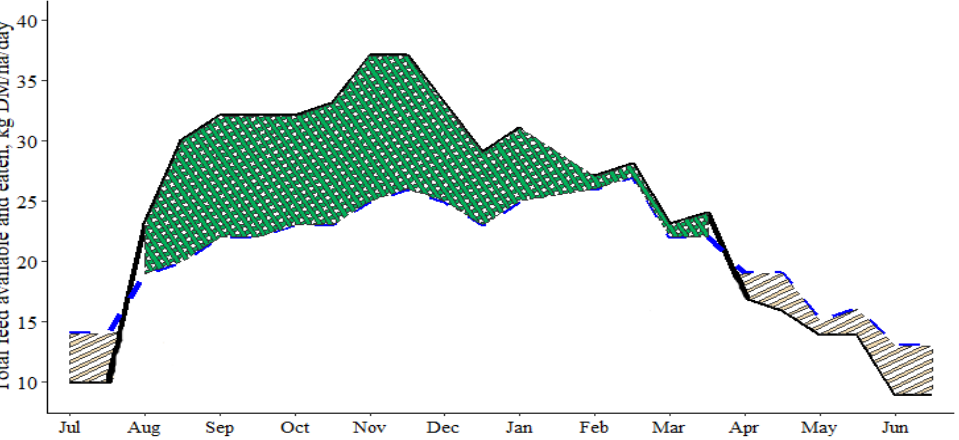
Figure 4. Utilizable pasture supplied (black line) and eaten by the beef cattle activity (blue dashed line which included silage) in the optimized farm system throughout the year. The excess available herbage (i.e., neither utilized nor processed for silage) is indicated by the green shaded area and the deficient available herbage (i.e., where cattle requirements were greater than the available pasture) which was supplemented with silage is indicated by the striped area.